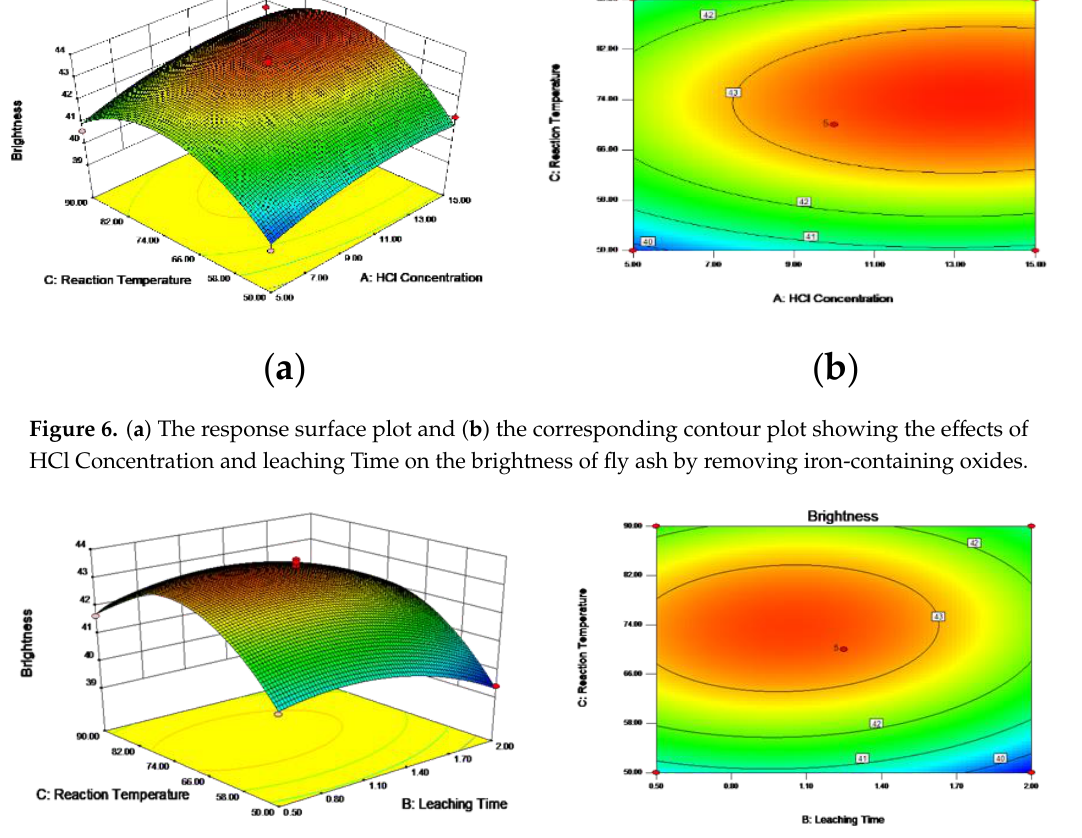
( b ) Figure 5. ( a ) The response surface plot and ( b ) the corresponding contour plot showing the effects of